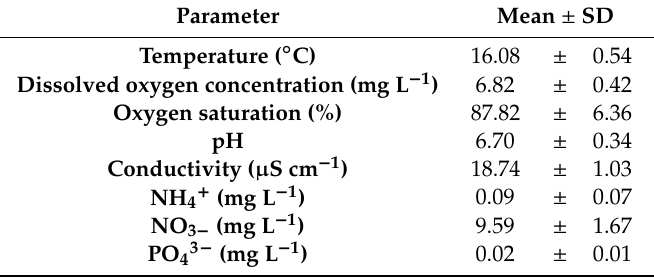
Table 2. Mean and standard deviation (SD) of the physicochemical parameters of